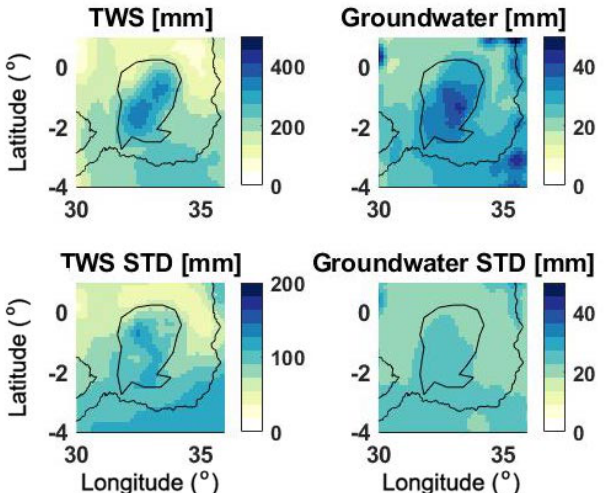
Figure 8. Temporally averaged TWS and groundwater values, both calculated for the period of January 2019 to July 2020 from data assimilation. The corresponding STD maps calculated from data assimilation are displayed in the bottom